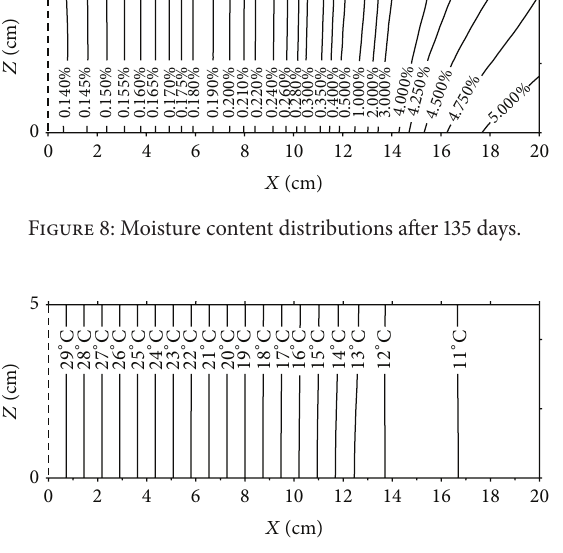
Figure 12: Distribution of vapour mass flow (in kg/m 2 ⋅ s) for 𝑡 = 4 days.